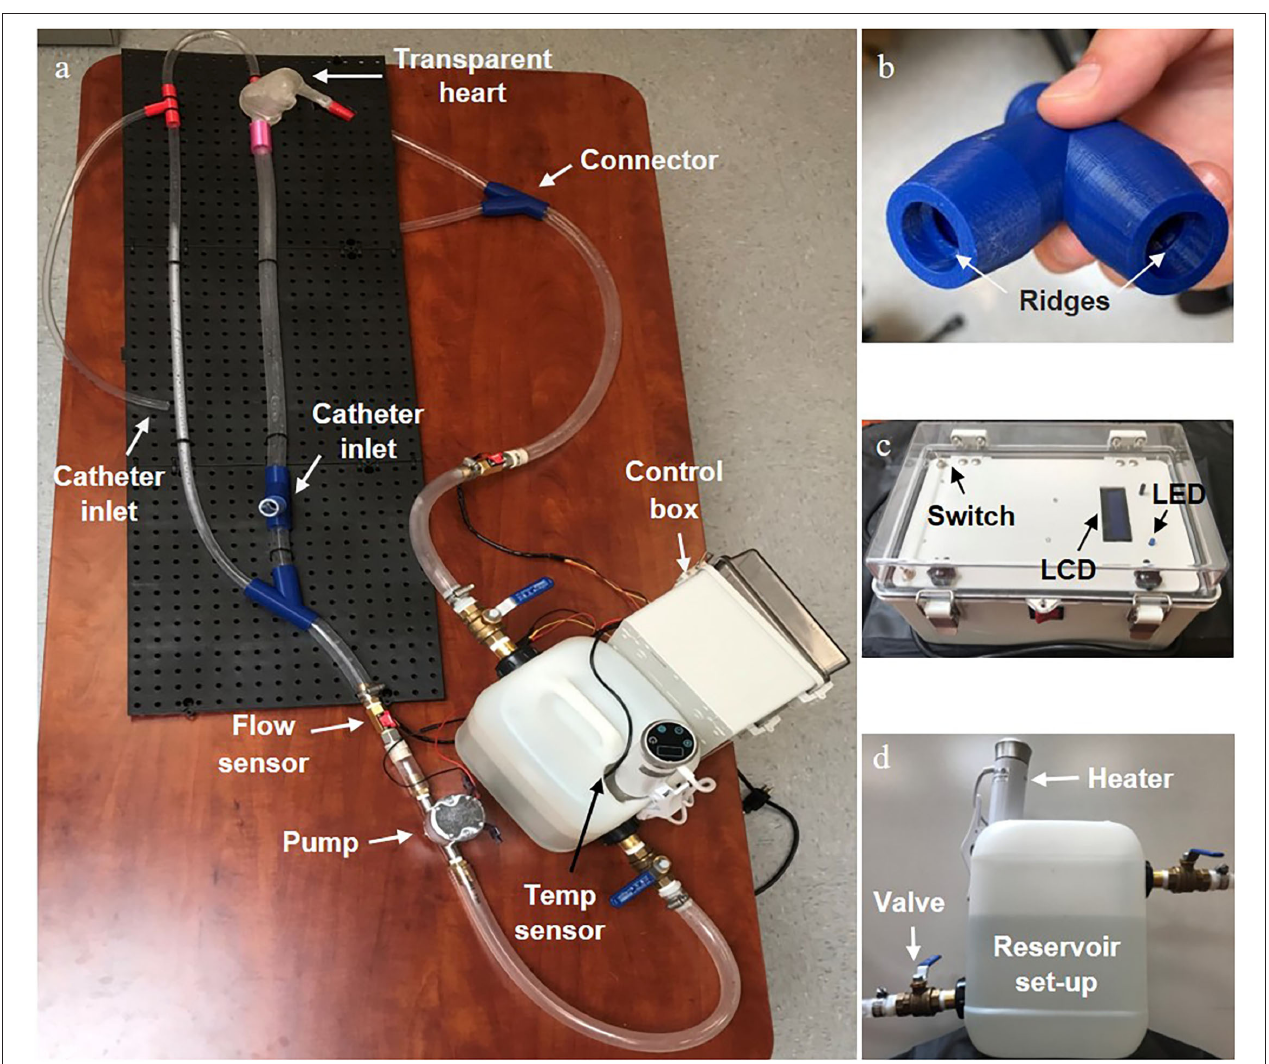
FIGURE 4 | Final physical vascular flow simulator. (a) The entire set-up with the main individual components labelled. (b) An enlarged view of the 3D printed connector showing the ridges that created a water tight seal with the tubing. (c) A front view of the control box showing the LCD display screen, state switches on the opposite side corners, and LED status indicator. (d) A side view of the reservoir set up with the heating element and valves clearly